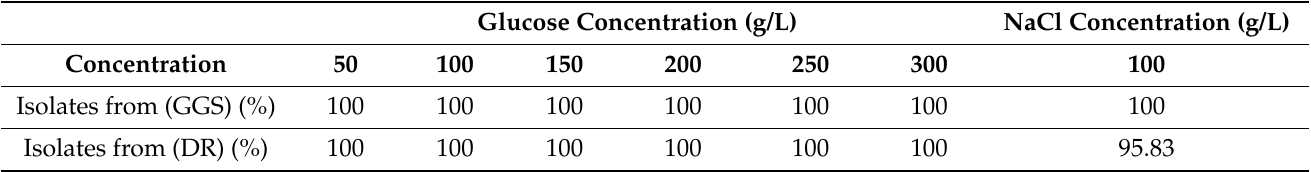
Table 5. Osmotolerance of isolates for glucose and